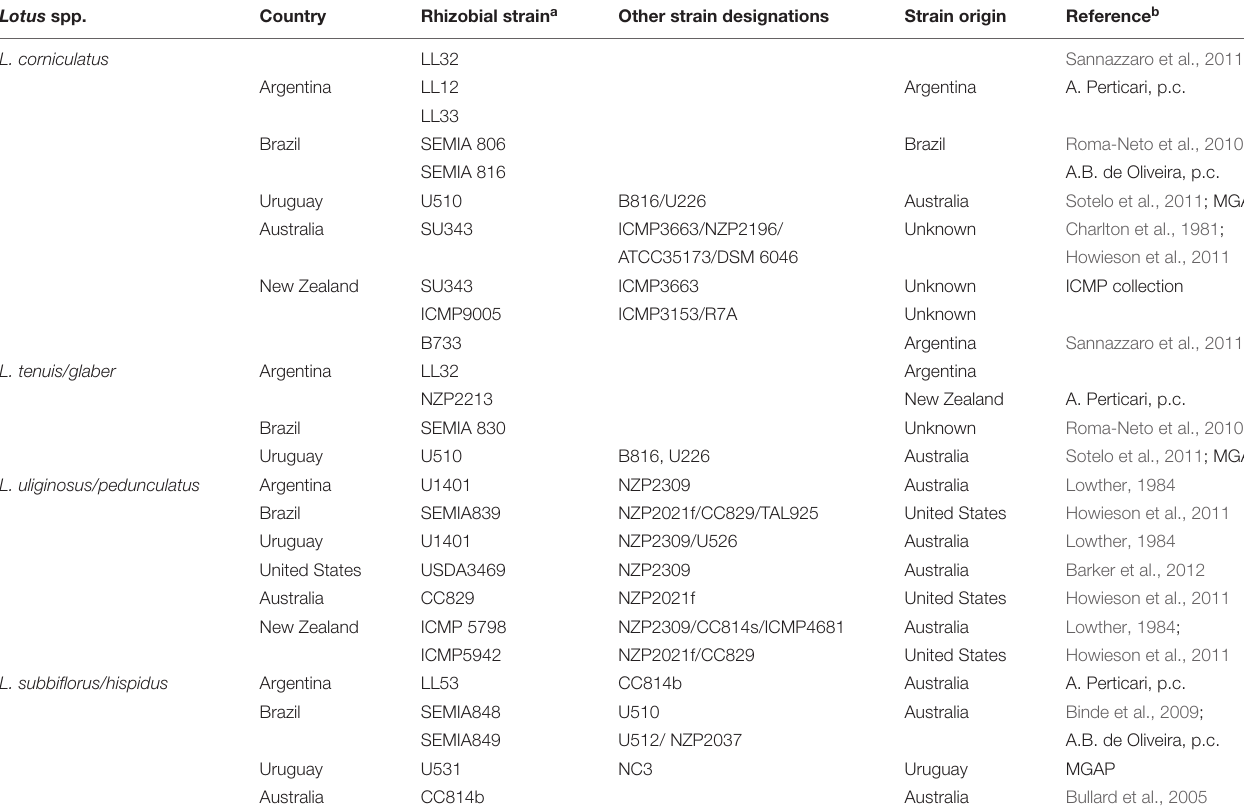
TABLE 1 | Rhizobial strains used for Lotus inoculants in different countries. Lotus